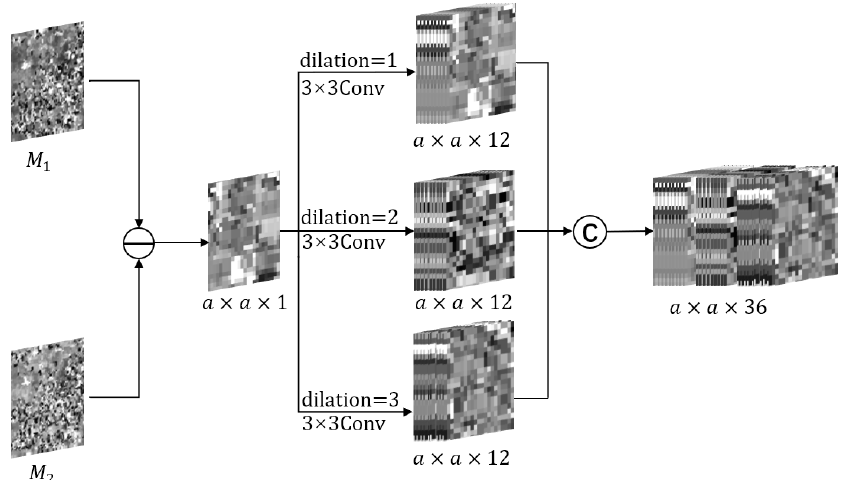
Figure 2. Network architecture of the multiscale